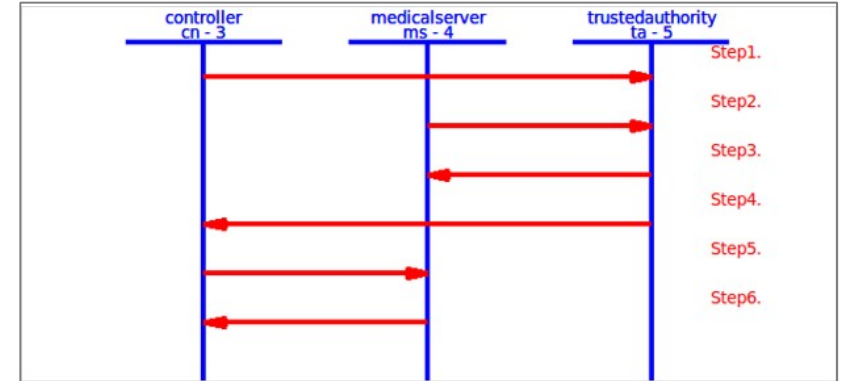
Figure 11. The SPAN animator of P-I.